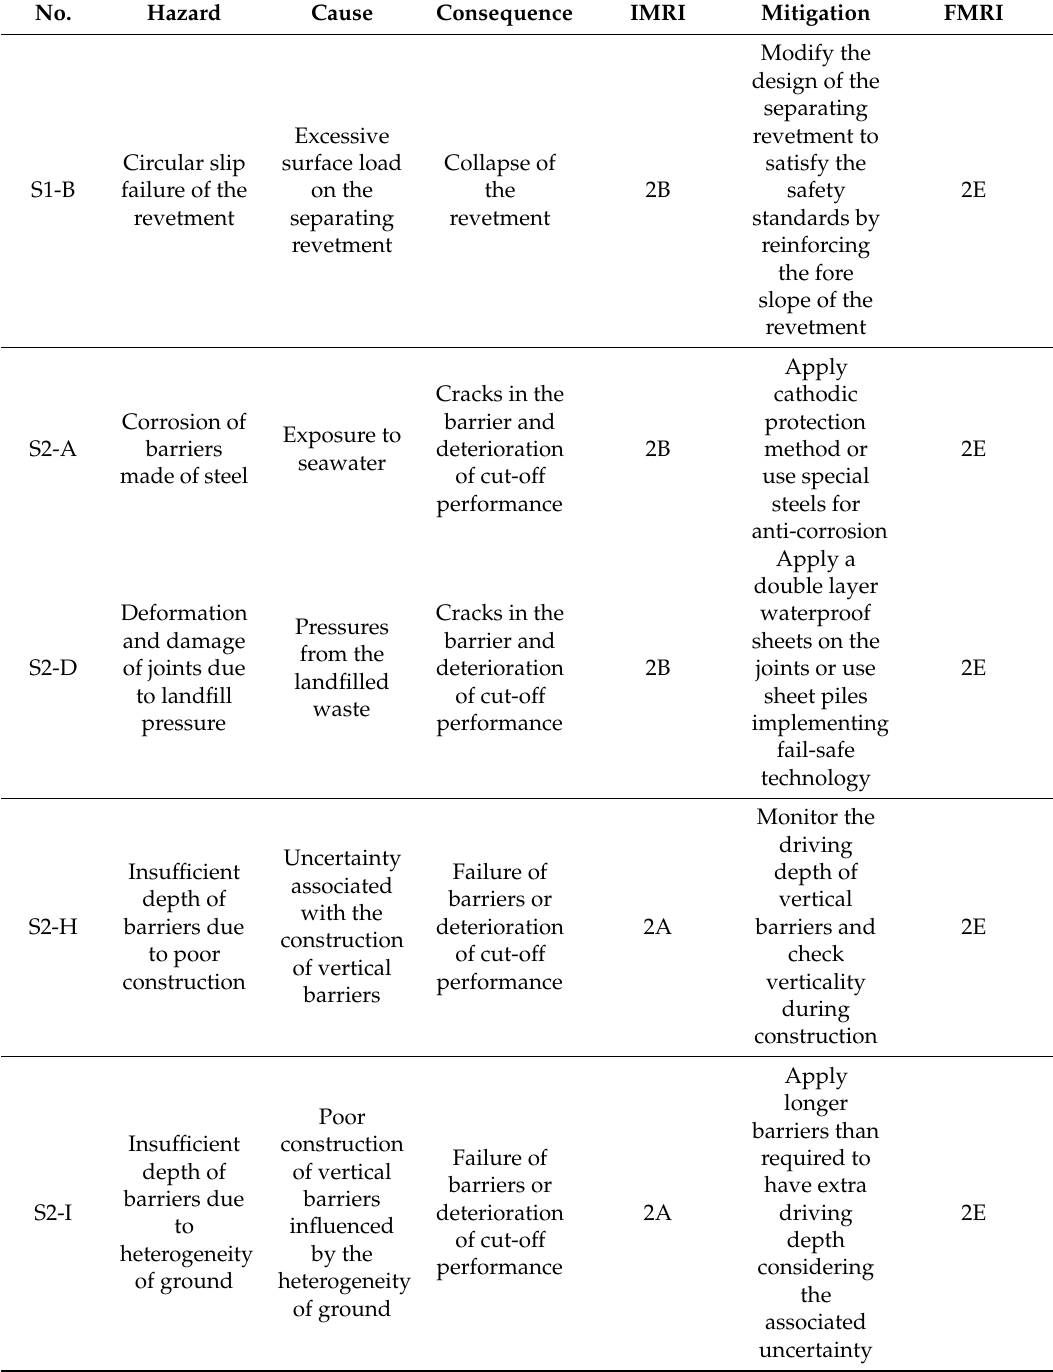
Table 6. Extremely hazardous elements identified by subsystem hazard analysis (SSHA) and